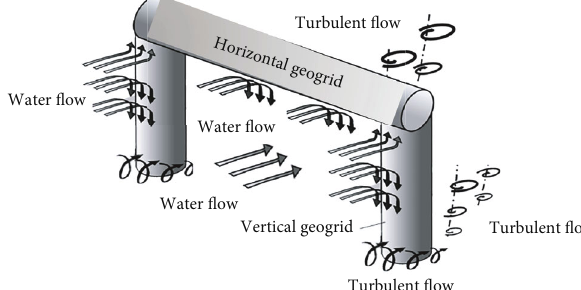
Figure 15: An illustration of the local scouring fl ow around the reinforcements exposed outside the tailing specimen; this part of the geogrid could be seen as a hydraulic structure, e.g., bridge